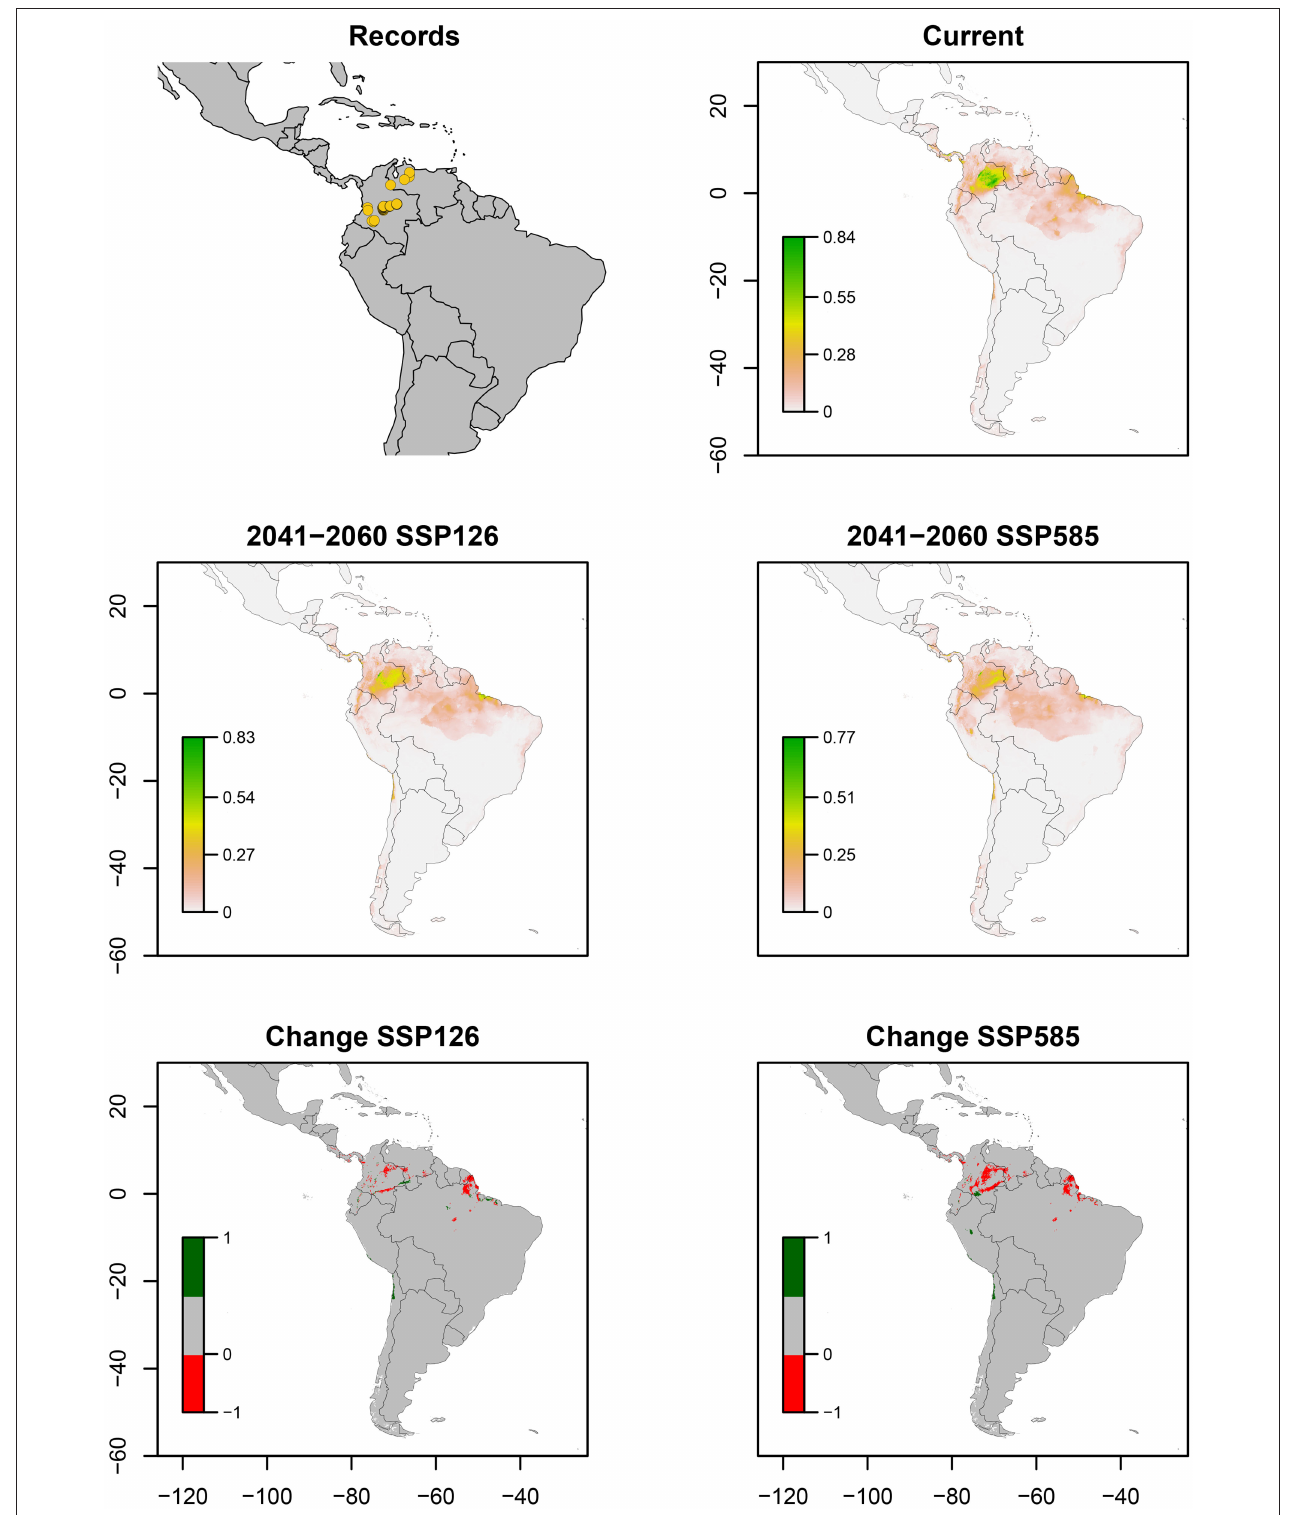
FIGURE 3 | Ecological niche models of Aeneolamia varia. Distribution records, current potential distribution, future potential distribution (2041–2060) under SSP126 and SSP585 scenarios, and comparison between current and future scenarios (change SSP126 and SSP585). The scale shows the habitat suitability being 1 = higher suitability. Scale in change maps − 1 = possible extinction and 1 = possible